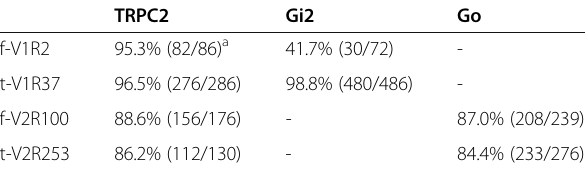
Table 1 Coexpression ratios of V1R and V2R genes and VNO- related genes in bichir olfactory